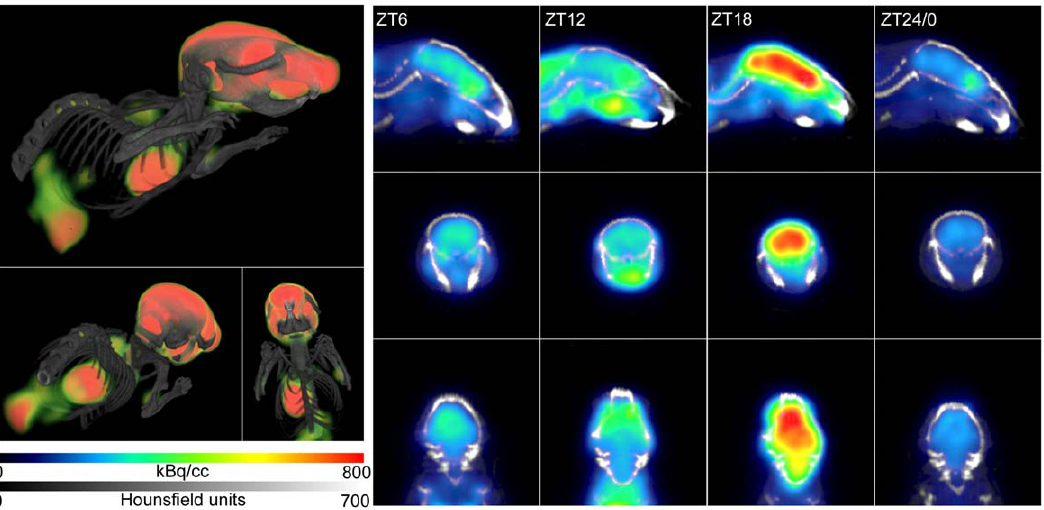
Figure 1. Fused CT and PET images from individual representative C57Bl/6 mice. The left panel shows a 3D reconstruction of a mouse measured in the middle of the dark phase of the light-dark cycle, where brain, heart and bladder show high FDG uptake. Both kidneys and the interscapular brown adipose tissue are also visible. Colors indicate only mid-range FDG uptake, where green is lower and red is higher uptake. On the right, representative individuals from the 4 groups measured at (from left to right) ZT6, 12, 18 and 24/0 are depicted. Images are shown for sagittal (top), coronal (middle) and transverse (bottom) planes. Scale bars belonging to the right panel for CT intensity (represented as gray-scale) and FDG uptake (in color) are shown on the bottom left.